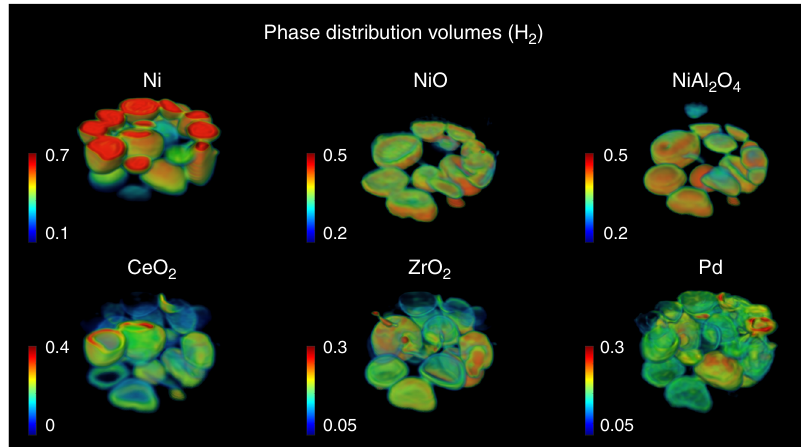
Fig. 3 Catalyst activation process. Volume rendering of the normalised scale factors (phase distribution volumes) obtained from the Rietveld analysis of the 3D-XRD-CT data collected at 800 °C under 20% H 2 /He fl ow. The values in the colorbar axes have been chosen to achieve the best